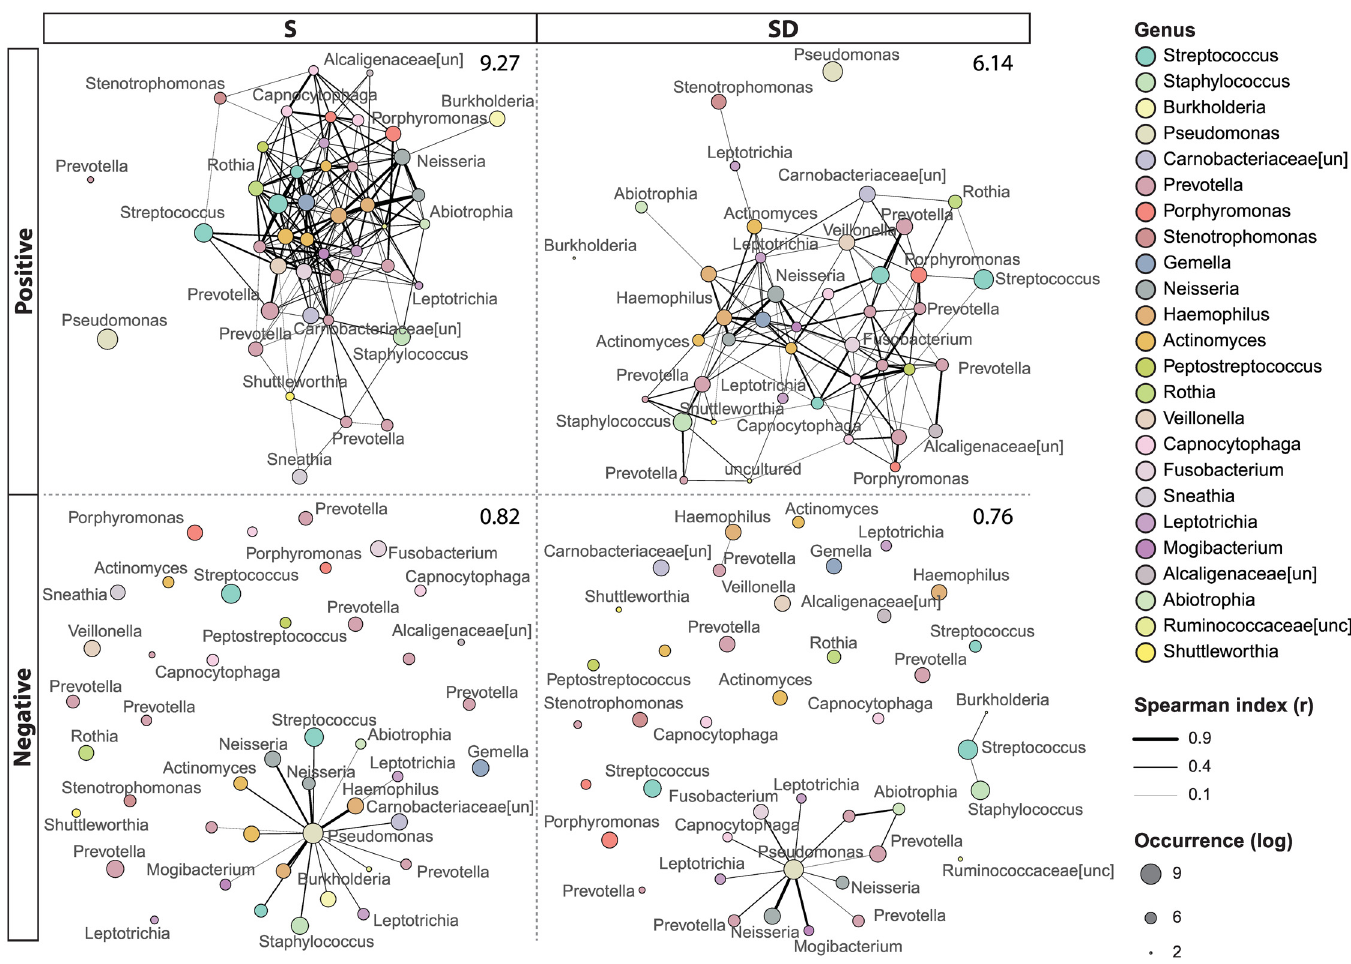
Fig 4. OTU Networks based on correlation analysis. Networks report positive and negative correlations between OTUs found in the airway microbiota of S and SD patients. Node color corresponds to taxonomic assignments, whereas node size reflects the log-transformed abundance. Edge thickness is proportional to the modulus of Spearman's rank correlation coefficient. Average degree values are reported in the upper-right corner of each